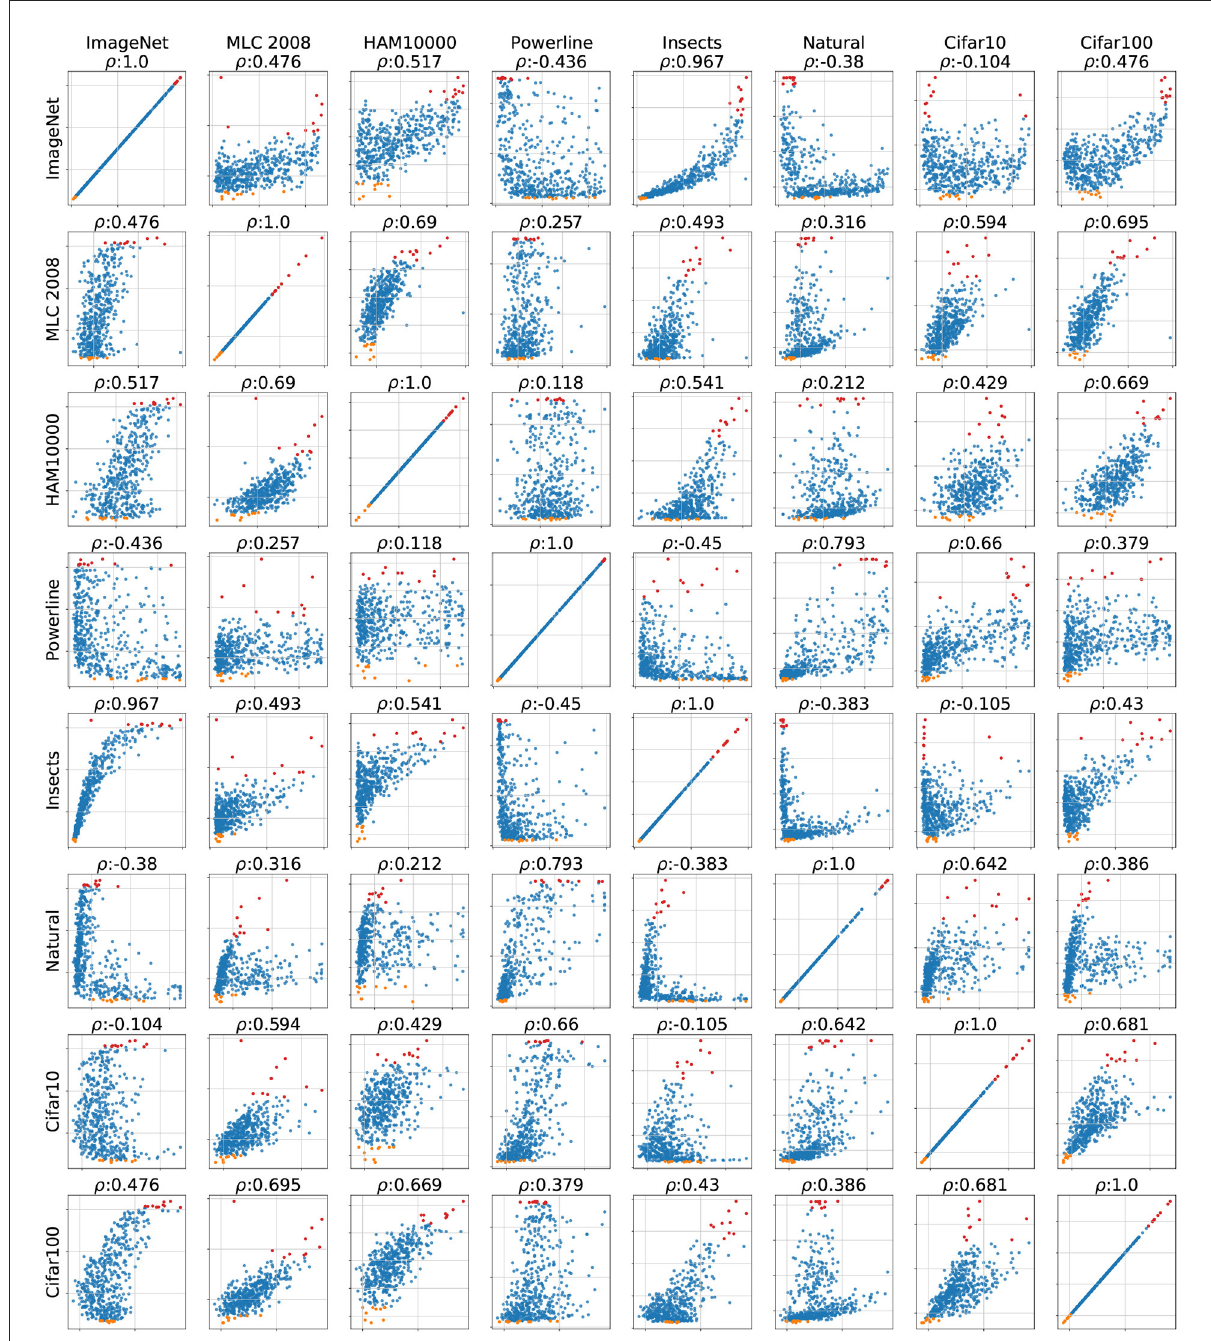
FIGUREA8 Matrix of error scatterplots of all datasets except Concrete (the first row replicates plots shown in Figure